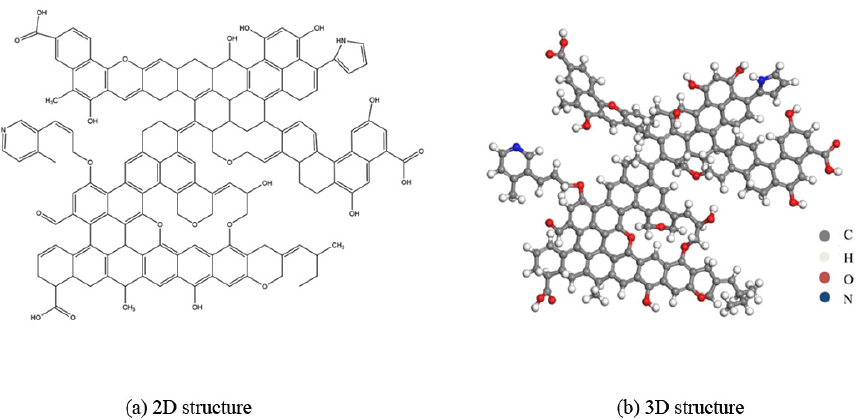
Figure 4. Two-dimensional structure ( a ) and initial 3D structural model ( b ) of Kerjian coal. Table 6. Molecular structural parameters of Kerjian coal. Molecular Structure